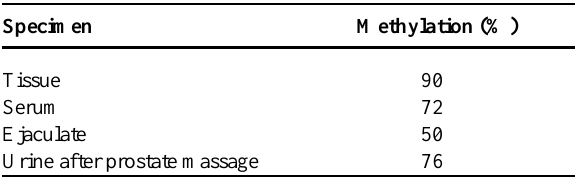
Table 2 – GSTP1 methylation in prostate cancer